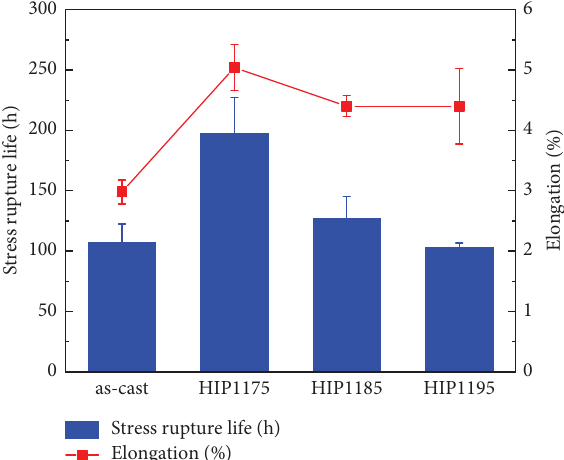
Figure 7: Average size and area fraction of c ′ precipitates in diferent conditions of the K417G alloy.